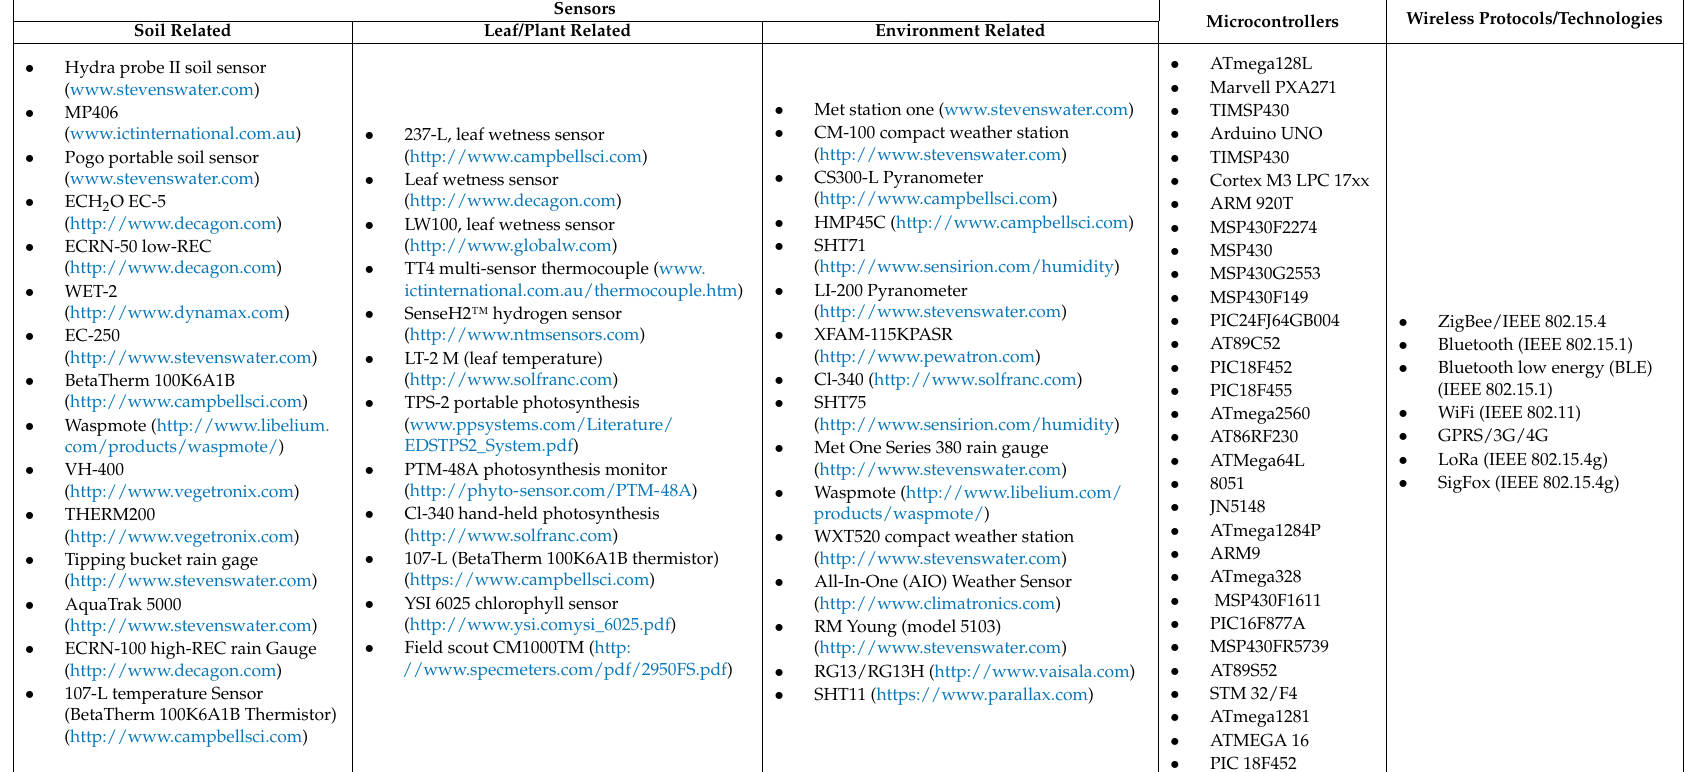
Table 9. Types of sensors, microcontrollers, and wireless protocols/technologies used in precision agriculture (PA).